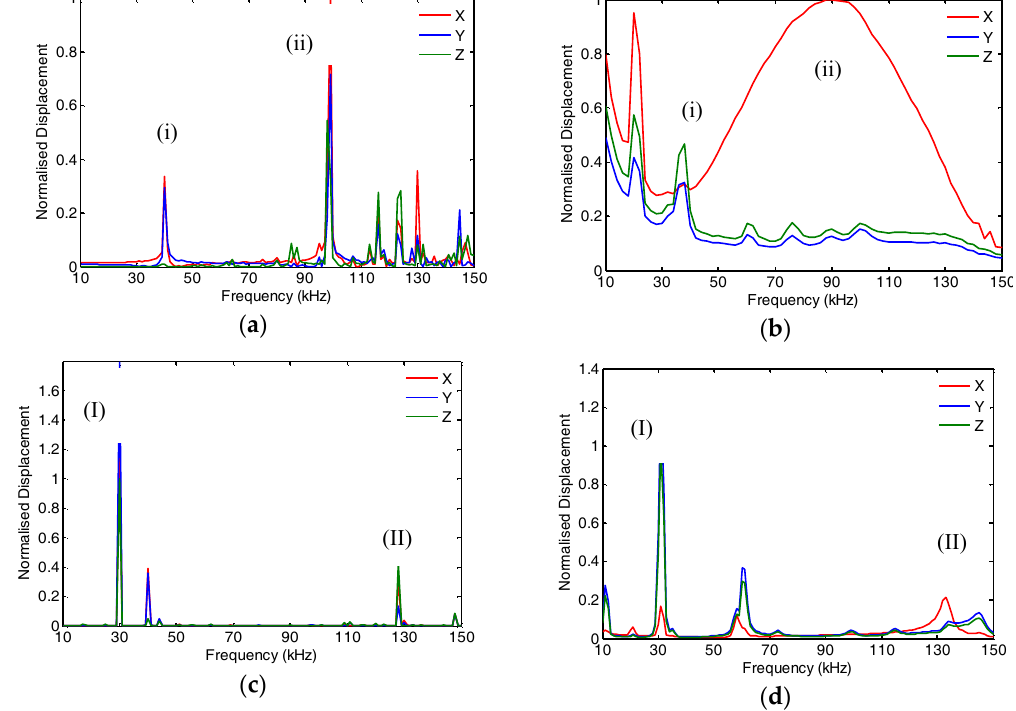
Figure 4. Frequency response of Y-cut GaPO 4 transducer with parallel electrodes ( a ) measured and ( b ) modelled compared ( c ) measured and ( d ) modelled results with wrap-around electrode. X , Y & Z are the displacement along length (shear), width (lateral) and thickness (out-of-plane)